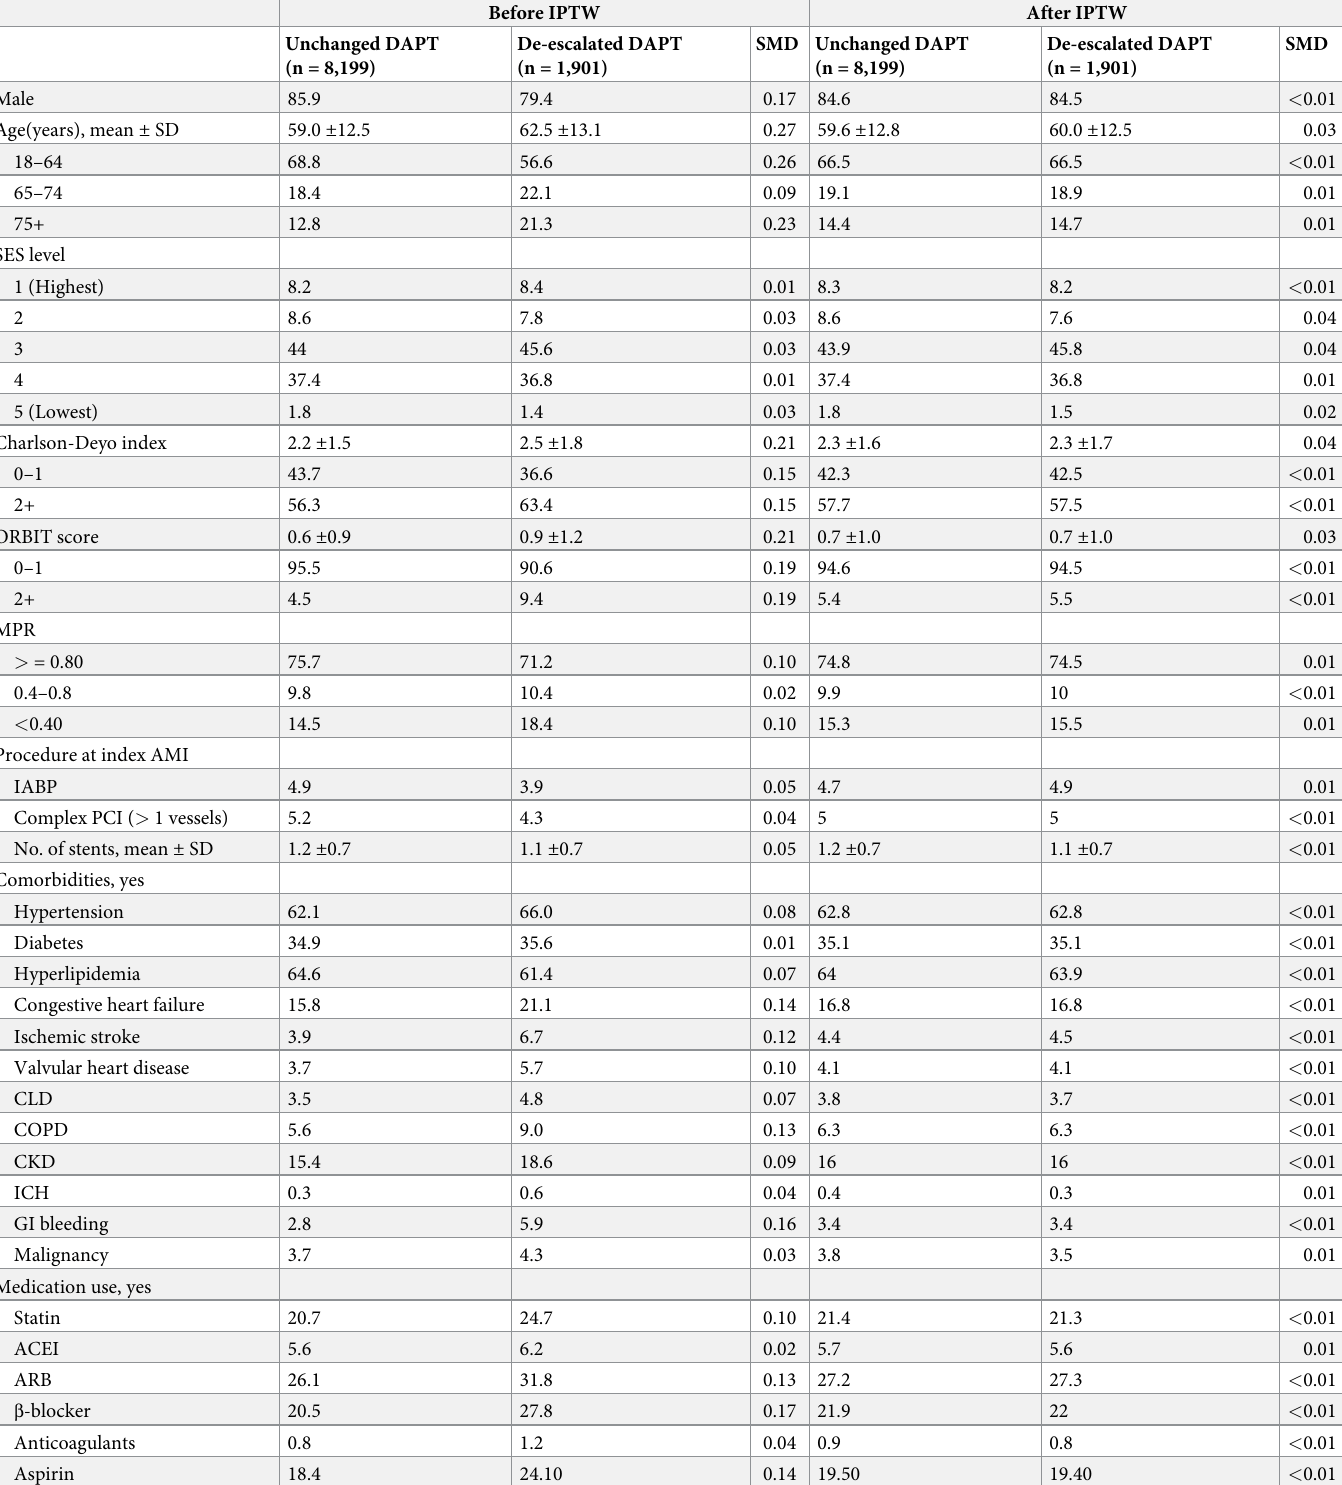
Table 1. Baseline characteristics of patients in unchanged DAPT group versus de-escalation DAPT